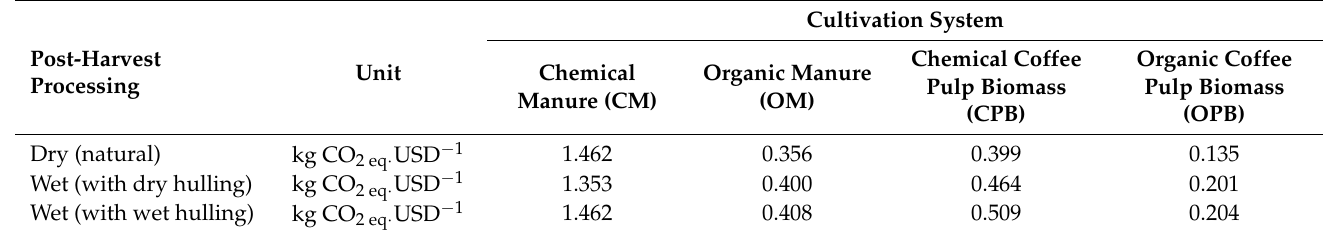
Table 6. The eco-efficiency index in coffee production in the upstream to